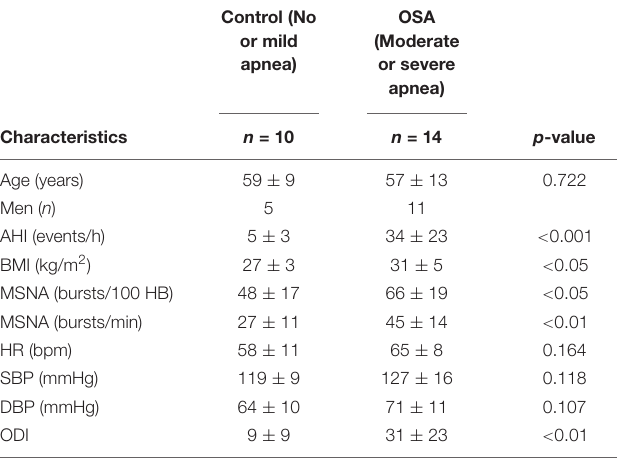
TABLE 3 | Participant characteristics: subgroup meeting fMRI analysis